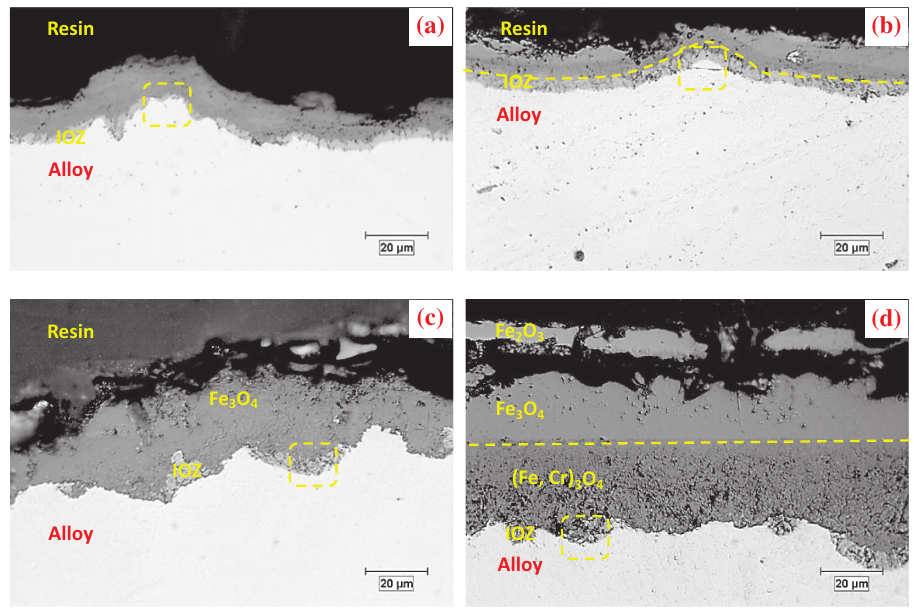
Figure 4: Cross-section morphologies of T92 steel with WE finish after different times: (a) 12.5h, (b) 25h, (c) 50h, and (d) 100h.